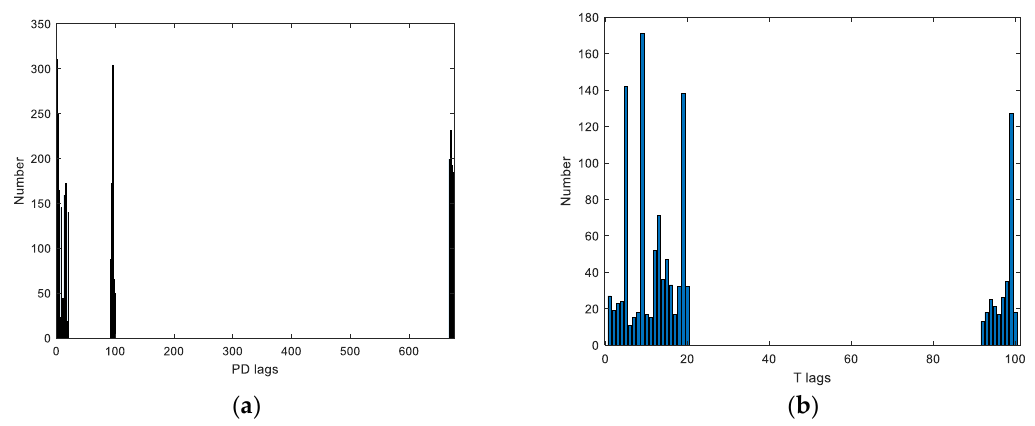
Figure 9. Histogram of the lags ’ usage in the non-dominated M 1 models: ( a ) P D ; ( b ) T.